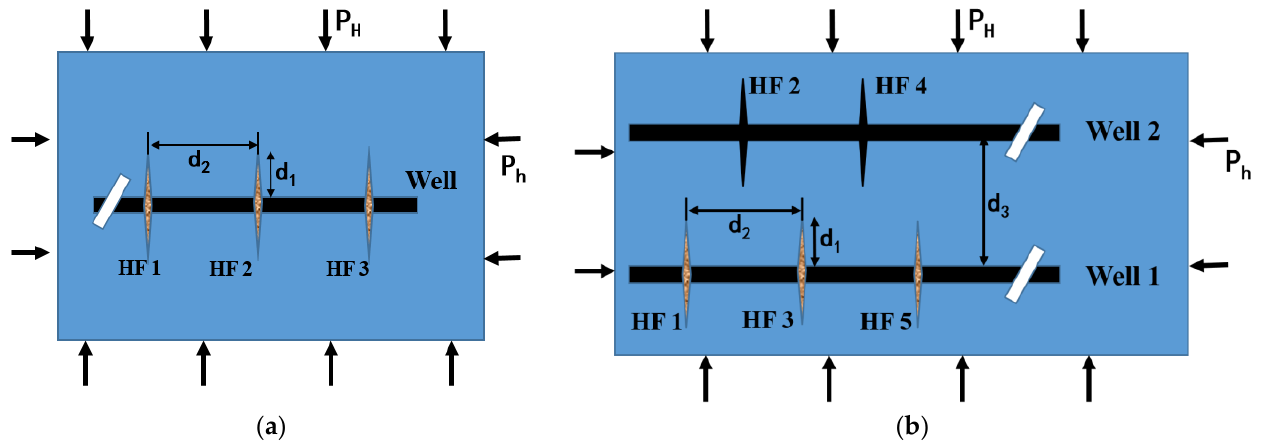
Figure 4. Physical model of sequential fracturing ( a ) in a single horizontal well; ( b ) in a double horizontal well, where: d 1 represents the perforating depth and d 2 represents the fracturing spacing in a well, and d 3 represents well spacing. P h and P H represent the minimum and maximum horizontal principal stress sequentially. Hydraulic fracture number represents the fracturing sequence.